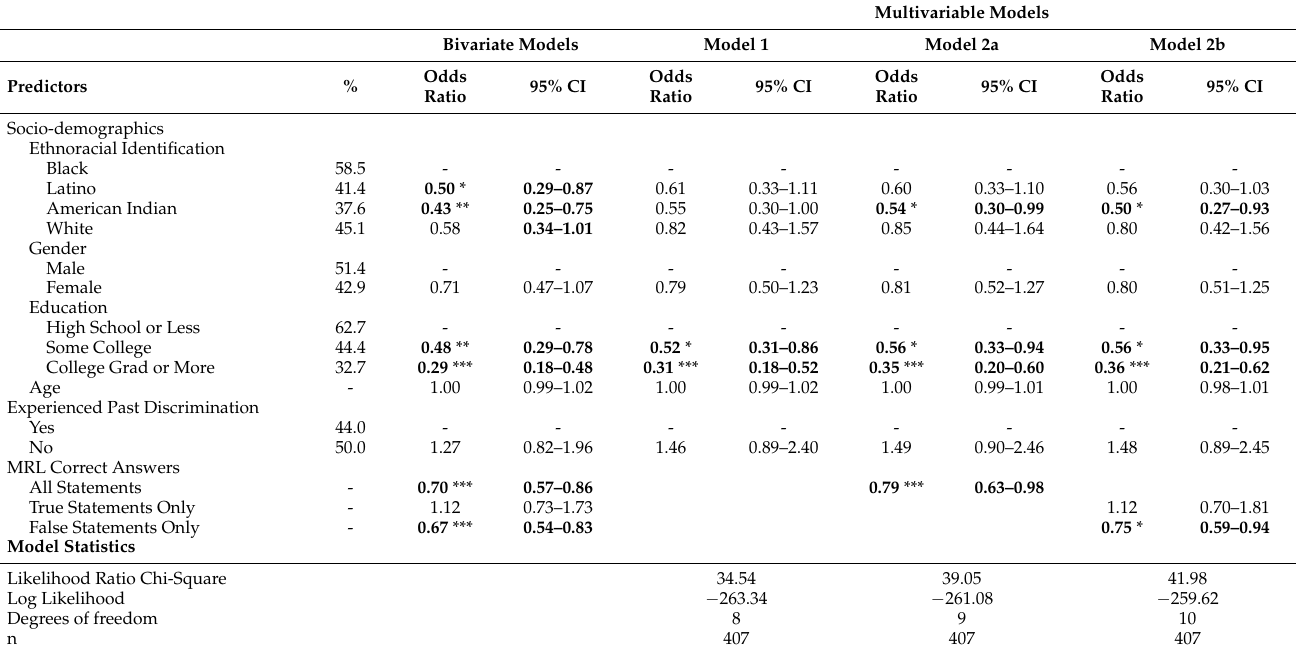
Table 7. Logistic Regression Models of Expressed Likelihood to Participate in a Clinical Trial on Socio-Demographics and Medical Research